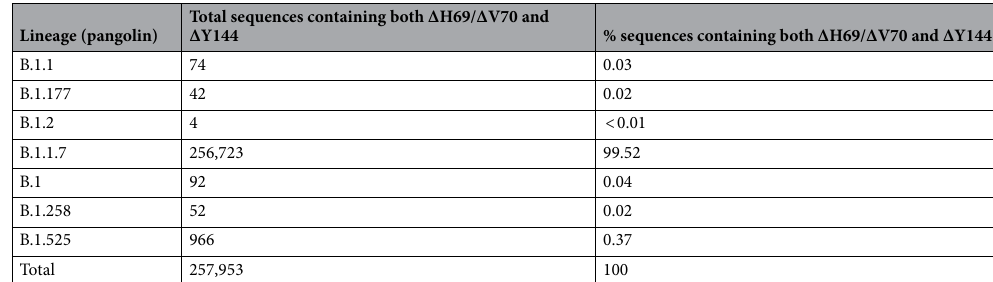
Table 1. Summary of GISAID sequences containing both Spike ΔH69/ΔV70 and ΔY144